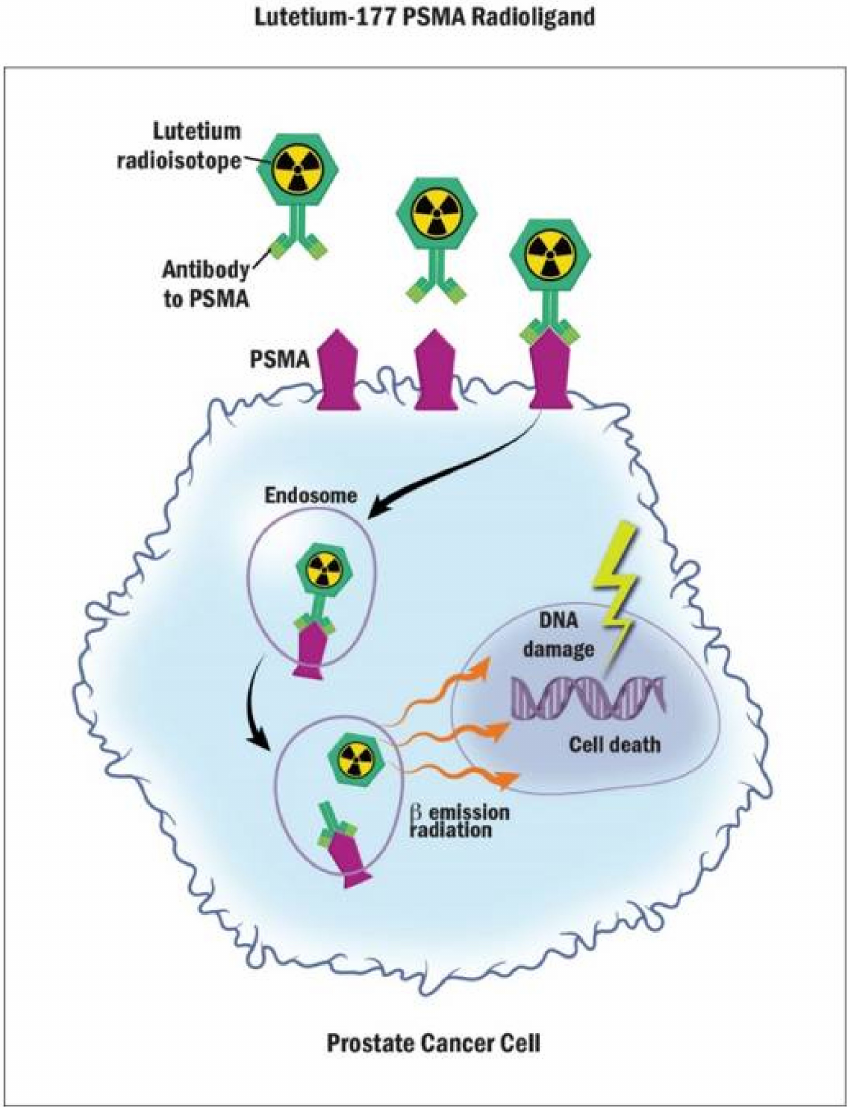
Figure 2. Mechanism of Action of Lutetium-177 PSMA